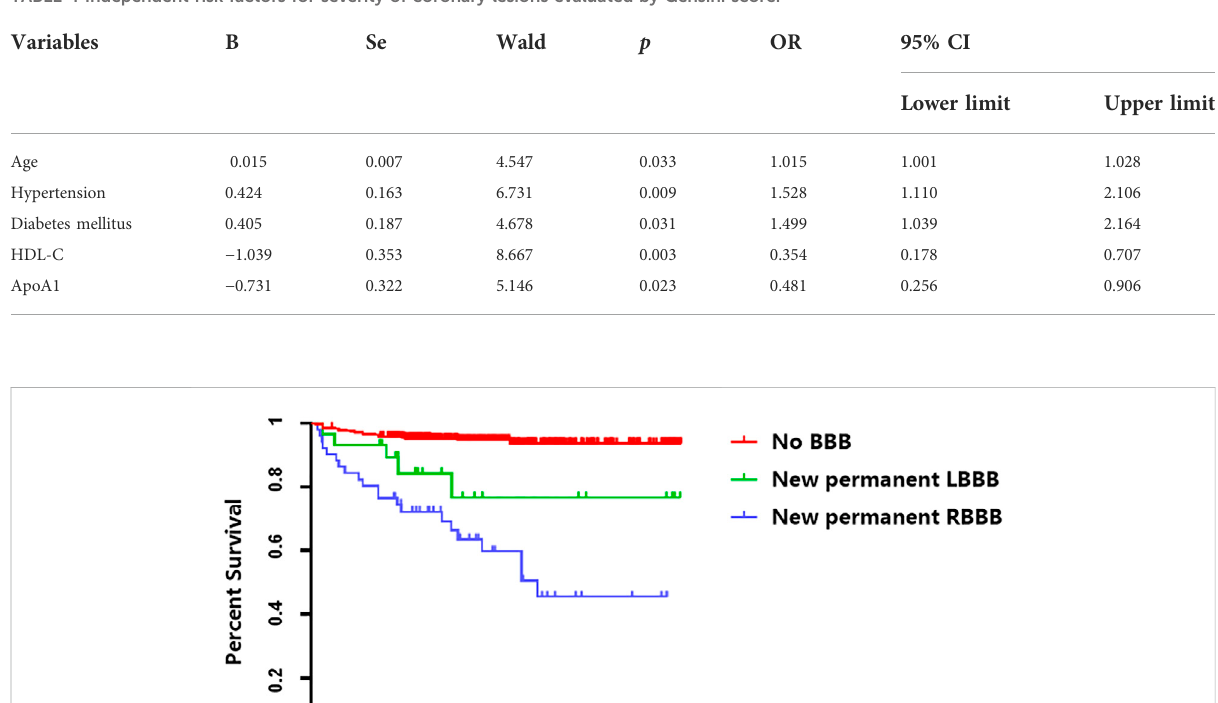
TABLE 4 Independent risk factors for severity of coronary lesions evaluated by Gensini score.